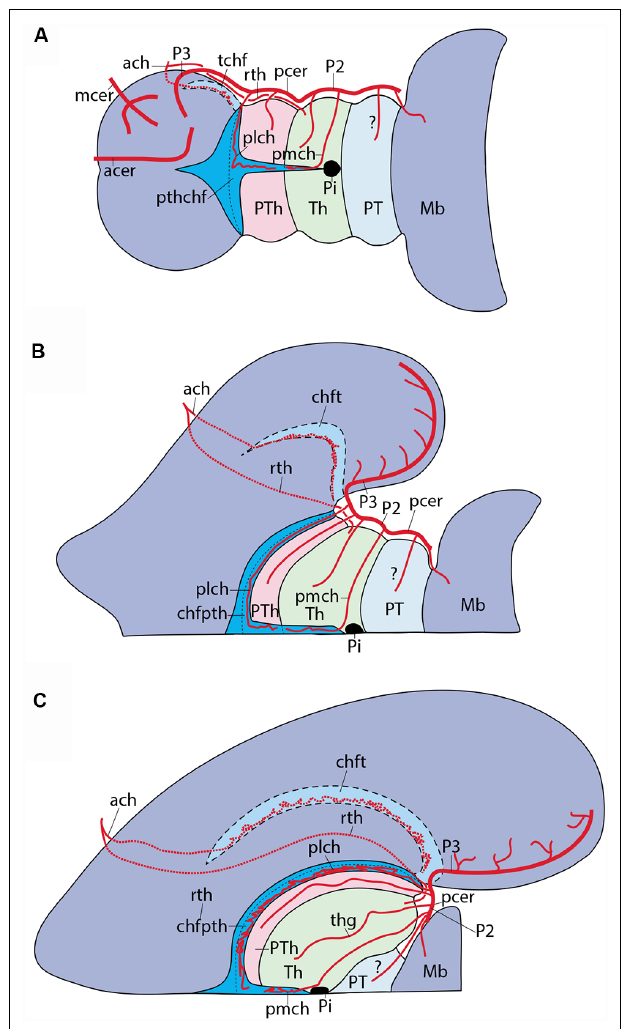
FIGURE 9 | (A–C) Schemata of dorsal views of the forebrain, representing three arbitrary developmental stages in which the diencephalo-telencephalic transition evolves dramatically due to the massive growth of the telencephalon, accompanied by disproportionate growth of the thalamus (Th) with respect to pretectum (PT) and prethalamus (PTh) in the diencephalon. (A) Initial stage, shortly after telencephalic evagination begins. A color code was applied to the three diencephalic alar territories, and the visible chorioidal roof mainly associated to the prethalamus was represented in brilliant blue, while the final telencephalic portion extends out of our view in all three schemata (seen by transparency in pale blue) into the primitive posterior pole of the hemisphere (the uncus). The pcer artery is disposed longitudinally along the whole alar diencephalon and finally reaches its telencephalic terminal region. We see also the acer and the mcer reaching independently their respective fields. Pretectal, thalamic and prethalamic alar branches arise sequentially from the pcer, as it contours each neuromere, and we see also the pmch reaching the thalamic roof and the plch reaching the prethalamic roof. Separately, the ach reaches the caudal tip of the telencephalic chorioidal fissure (by transparency). (B) At this stage, the hemisphere starts to bulge caudalwards and the thalamic mass grows jointly with the internal capsule as it bridges the hemispheric stalk in front of the prethalamus. This development start to cause a stretching of the prethalamus and its associated chorioidal formation (pink plus bright blue). All the vessels are absolutely passive in